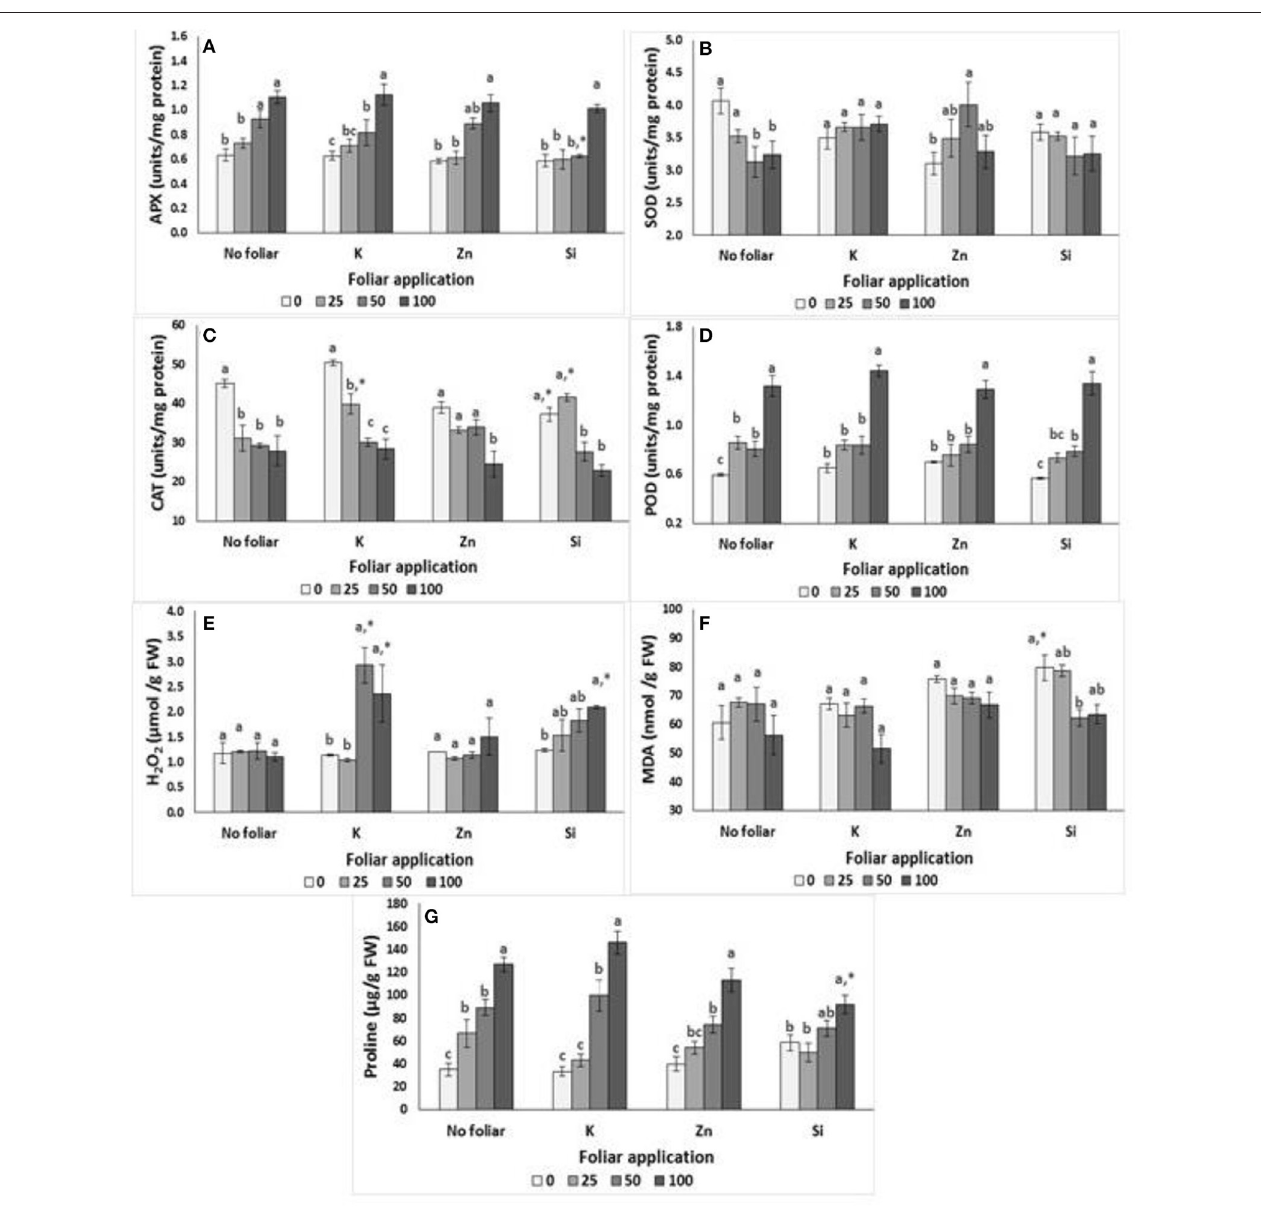
FIGURE 2 | Effect of salinity levels (0–25–50–100mM NaCl) and foliar applications (no foliar, K, Zn, Si) on the damage index and antioxidant enzymes activities in lavender. (A) APX, (B) SOD, (C) CAT, (D) POD, (E) H 2 O 2 , (F) Lipid peroxidation (MDA), and (G) proline. Significant differences ( P < 0.05) among salinity treatments are indicated by different letters. Star (*) symbol indicated significance differ among no foliar and equivalent cation foliar. Error bars show SE ( n = 6).